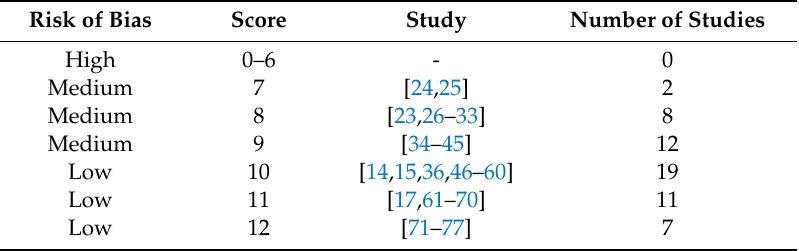
Figure 1. Search strategy Preferred Reported Item for Systematic review and Meta-Analysis (PRISMA) flow chart. Table 2. Risk of bias assessment.